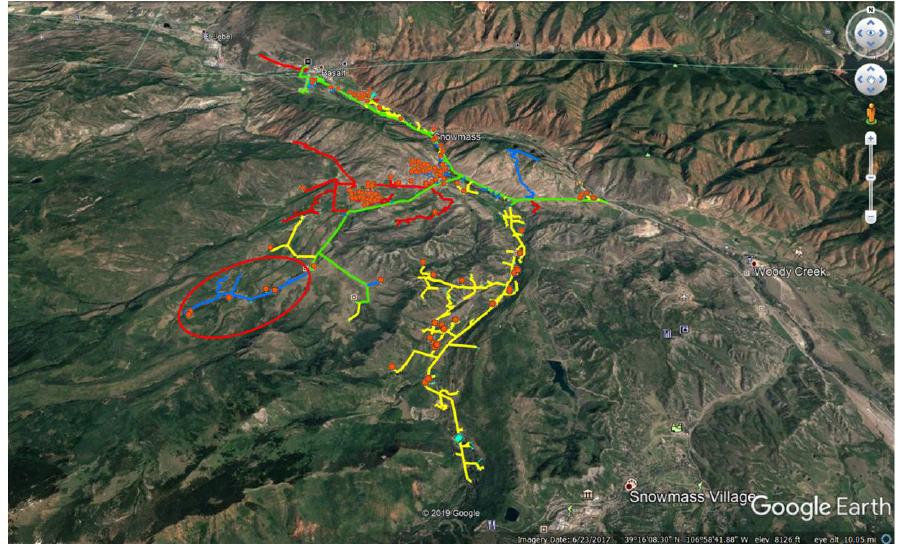
Figure 3. Topology of the real-world utility distribution feeder shown in Google Earth. Provided by HCE.